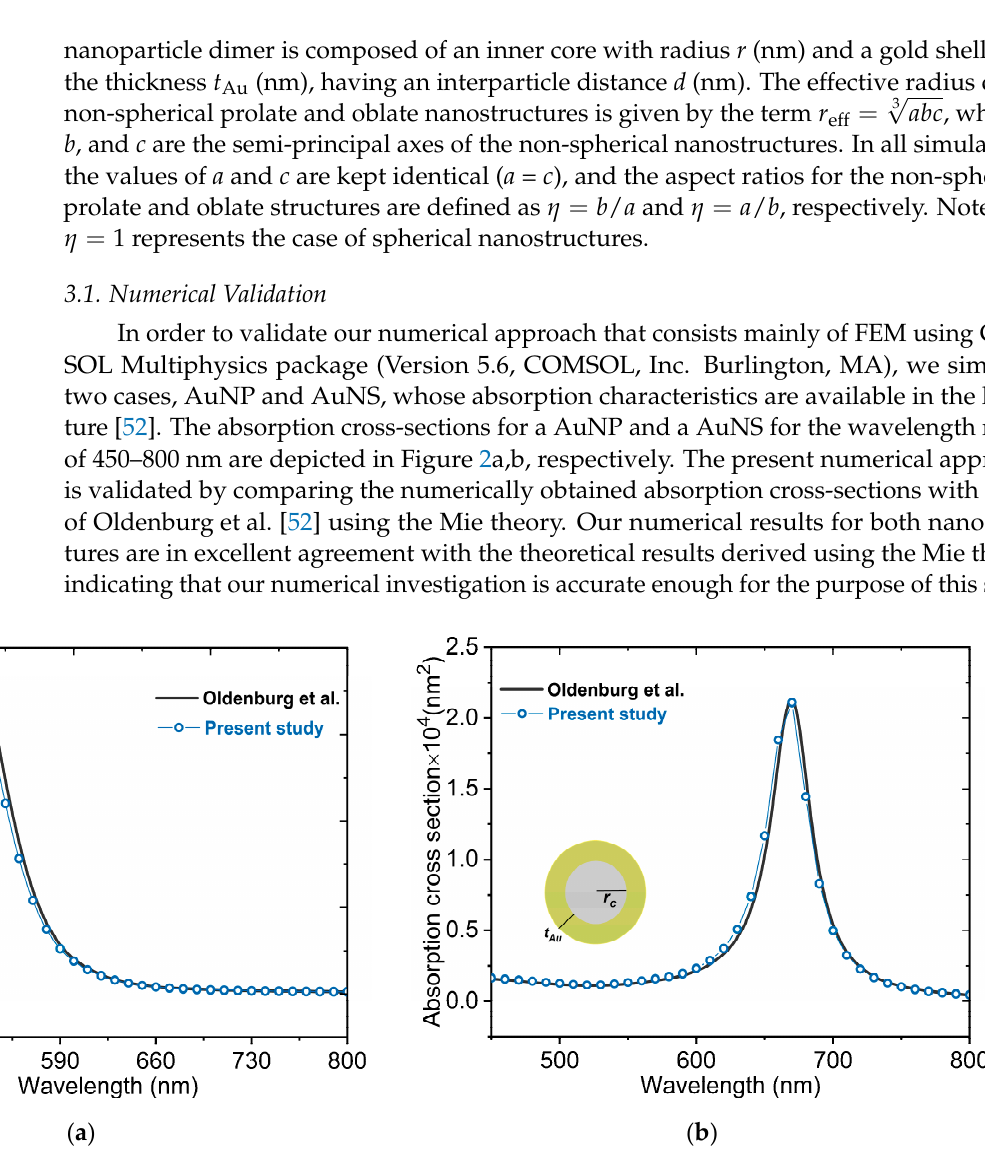
Figure 2. Validation of the present numerical model: Absorption spectra for the ( a ) solid gold nanosphere (AuNP) (𝑟 (cid:2885)(cid:2931) = 20 nm) and ( b ) silica-gold core-shell nanoshell (𝑟 (cid:2913) = 20 nm,𝑡 (cid:2885)(cid:2931) = 3 nm) as a function of the incident wavelength, compared to the Mie theory [52]. The nanostructures are surrounded by water with a refractive index of 1.33.